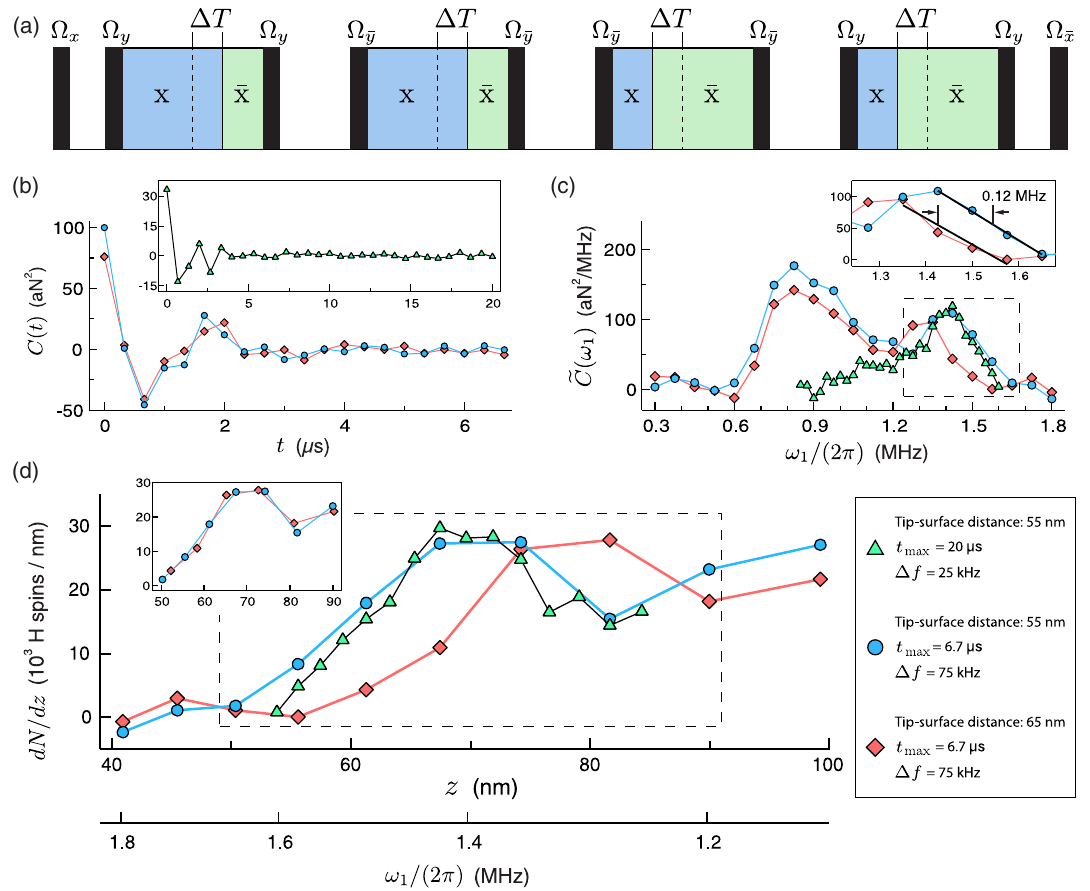
FIG. 5. One-dimensional imaging. (a) Modified SME4 spin sequence used for one-dimensional imaging includes time offsets ( Δ T ) during rotary evolution periods to encode Rabi frequency information. (b) Spin correlation data C ð t Þ after a single modified SME4 sequence as a function of rotary evolution time t ¼ 8 Δ T . The data displayed using the blue and red points were acquired with 0 . 33 - μ s steps at a tip-surface separation of 55 nm and 65 nm, respectively. The frequency resolution for both data sets is 75 kHz. (Inset) The green data points were acquired with 0 . 66 - μ s steps at a tip-surface separation of 55 nm. The frequency resolution for these data is 25 kHz. (c) Spectral density data. The sharp decrease in signal observed below 0.7 MHz for the 75-kHz resolution data and 1.2 MHz for the 25-kHz resolution data is due to the high-pass filter discussed in Sec. IV of Ref. [13]. (d) One-dimensional proton density as a function of height above the CFFGS. Tip-surface separation and frequency step size are the same for each data set as those in part (c). (Inset) 75-kHz resolution data, with the 65-nm data offset by 9 nm in the negative z [Fig. 5(a)] offset by an amount proportional to the total evolution time: Δ α ¼ Δ ω t [see Fig. 2(a) for the definition of the angle α ]. For the t ¼ 6 . 7 μ s and t ¼ 20 μ s data, max max the frequency shift was chosen to be Δ ω / ð 2 π Þ ¼ 300 kHz and Δ ω / ð 2 π Þ ¼ 850 kHz, respectively. The corresponding frequency range was 0.3 – 1.8 MHz ( t ¼ 6 . 7 μ s data) and max 0.85 – 1.6 MHz ( t ¼ 20 μ s data.) To prevent aliasing of max